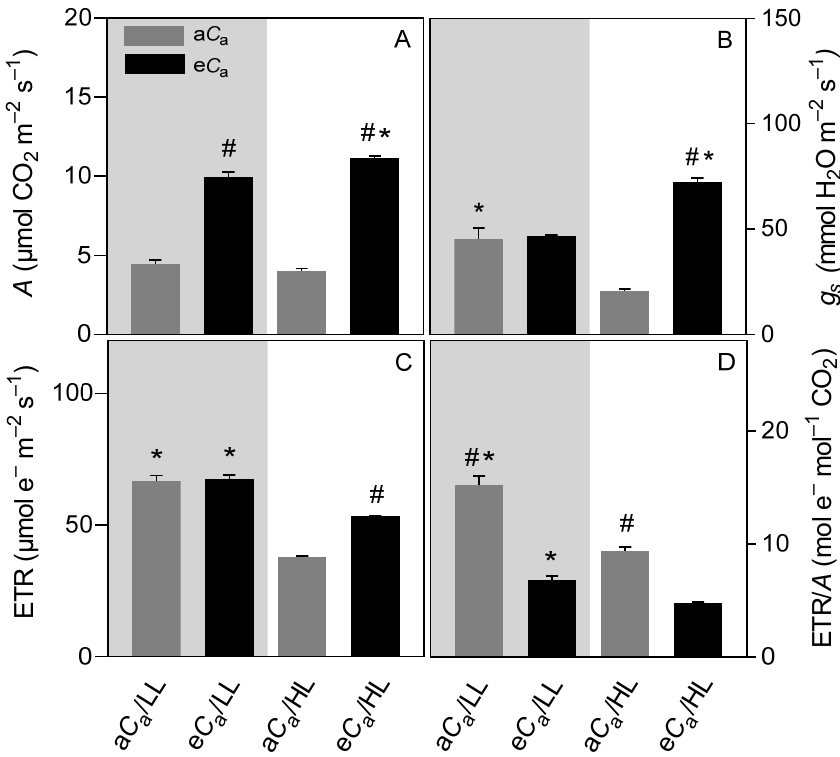
Figure 2. The effect of light transitions (grey area: plants grown at low light but evaluated at high light, 1000 µ mol photons m − 2 s − 1 ; white area: plants grown at high light but evaluated at low light, 200 µ mol photons m − 2 s − 1 ) and CO 2 supply [ambient (a C a ) or elevated (e C a ) supply] on the ( A ) net carbon assimilation rate ( A ), ( B ) stomatal conductance ( g s ), ( C ) electron transport rate (ETR), and ( D ) ETR/ A ratio. Asterisk (*), when shown, indicates differences between light regimes within the same CO 2 supply. Pound (#), when shown, indicates differences between CO 2 treatments within the same light regime ( p ≤ 0.05, F test, n = 6 ± SE).